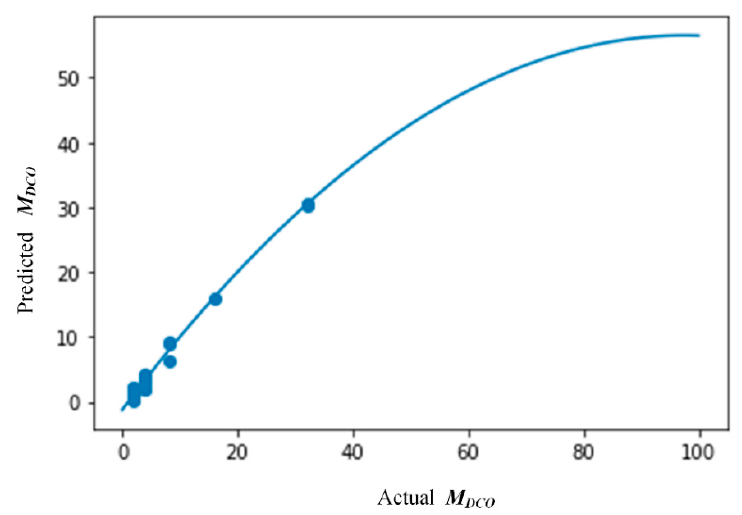
Figure 12. Predicted versus actual M DCO of dc-biased pulse amplitude modulated orthogonal fre- quency division multiplexing (DPO-OFDM) for the case of linear regression. Note that M DCO stands for the constellation size of DC-biased optical OFDM (DCO-OFDM).